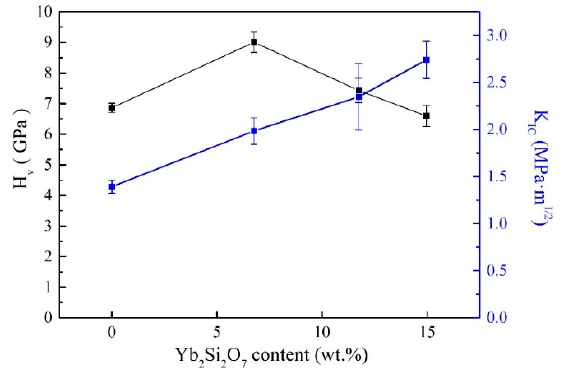
Figure 4. Vickers hardness and fracture toughness of the samples.